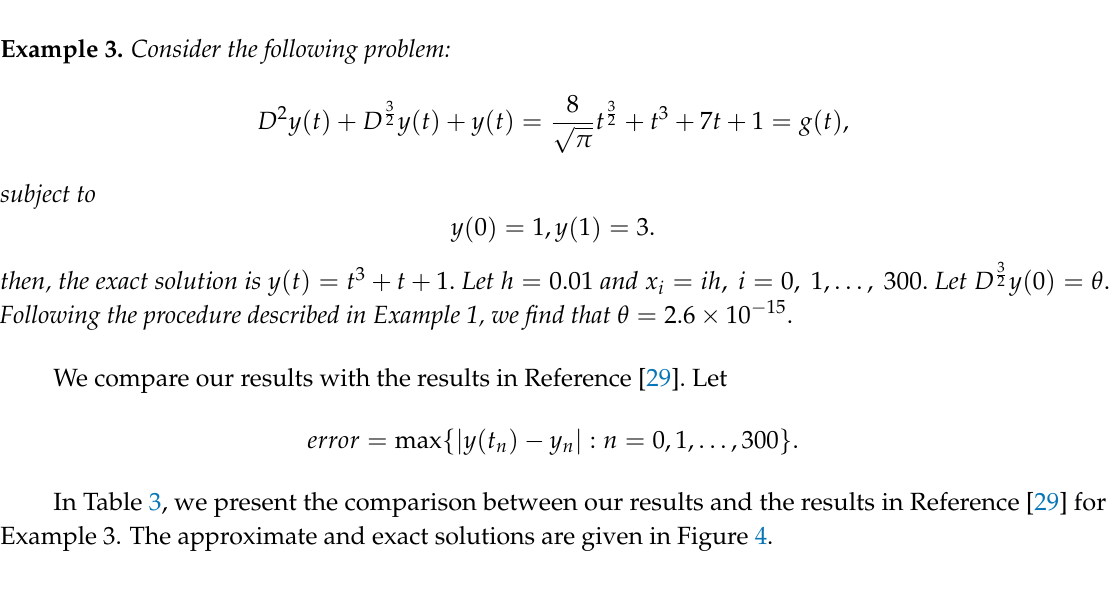
Figure 3. The exact and the approximate solutions for Example 2.